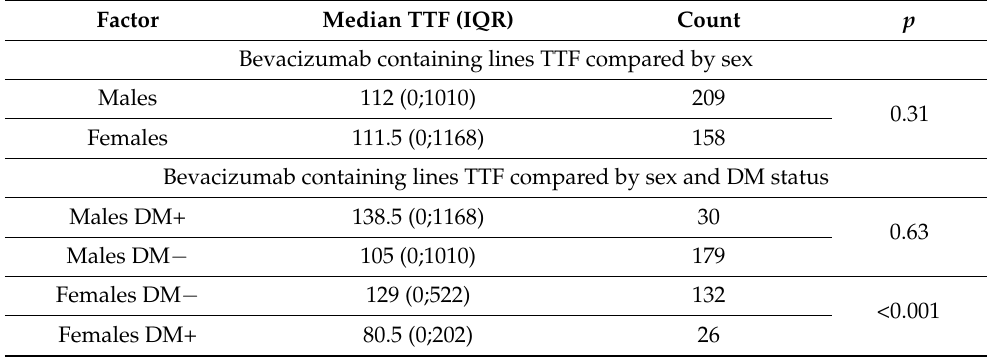
Table 7. The distribution of TTF for Bevacizumab containing lines.